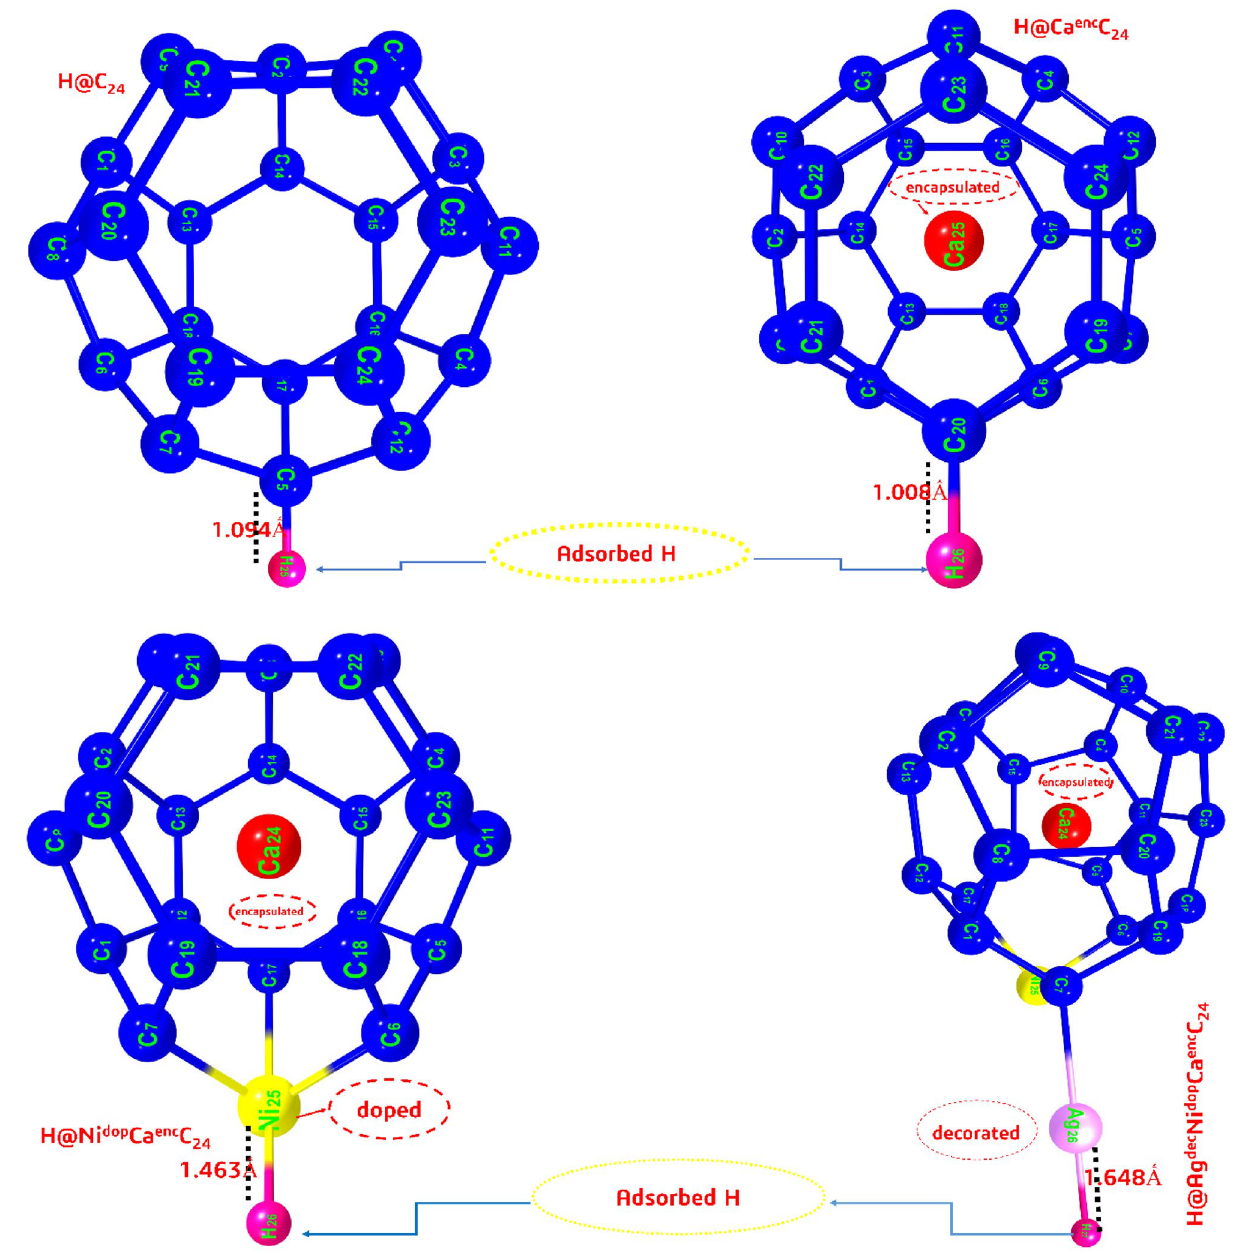
Figure 6. Structural illustration of the titled systems on adsorption of atomic hydrogen, with their respective bond